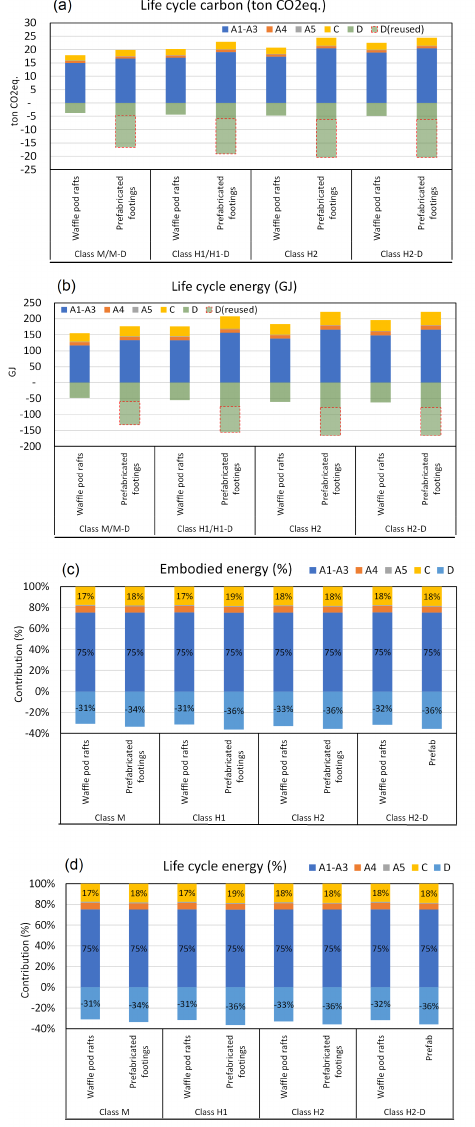
Figure 9. Comparison of the Life Cycle Energy and GHG emissions considering reactive site classifi- cation between the developed prefabricated footing systems and waffle rafts (( a , b ) show the amount of GHG emissions and energy consumption according to the life cycle of each stage. ‘D(reused)’ in ( a , b ) represents the energy and GHG reduction effect of the reuse of other sites after disassembly of the prefabricated footing systems). ( c , d ) do consider only recycling but do not consider reuse